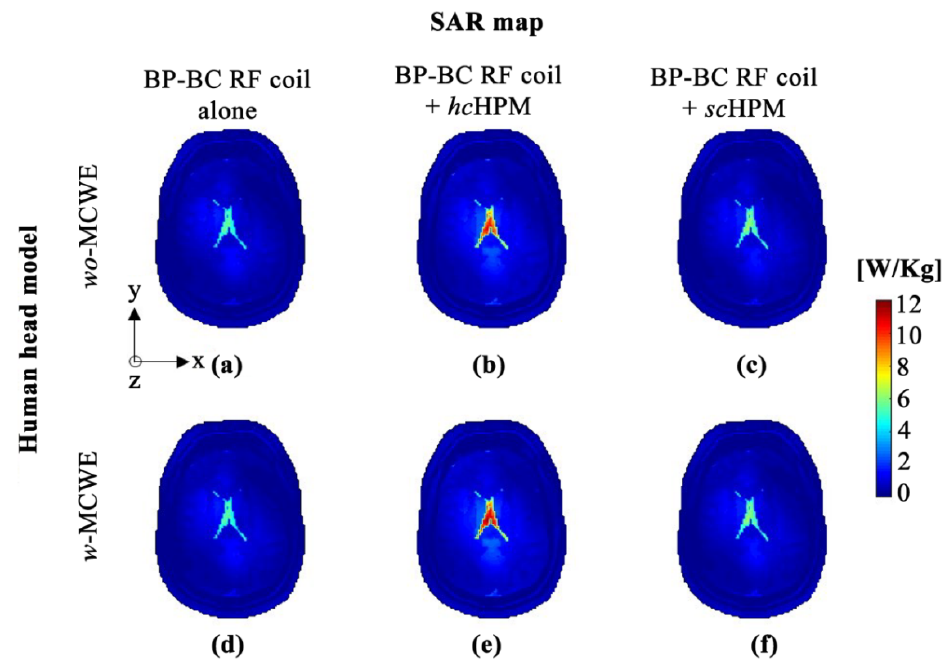
Figure 6. SAR map constructed using Norm-COEF values: ( a ) BP-BC RF coil alone − wo -MCWE; ( b ) BP-BC RF coil + hc HPM − wo -MCWE; ( c ) BP-BC RF coil + sc HPM − wo -MCWE; ( d ) BP-BC RF coil alone − w -MCWE; ( e ) BP-BC RF coil + hc HPM − w -MCWE; ( f ) BP-BC RF coil + sc HPM − w -MCWE. EM-field simulation results show that the | B (cid:2869) |-field sensitivity of the BP-BC RF coil, combined with MCWE and sc HPM, was greater than that of the BP-BC RF coil alone by about 32.130% for the cylindrical phantom and by 22.174% for the human head model.